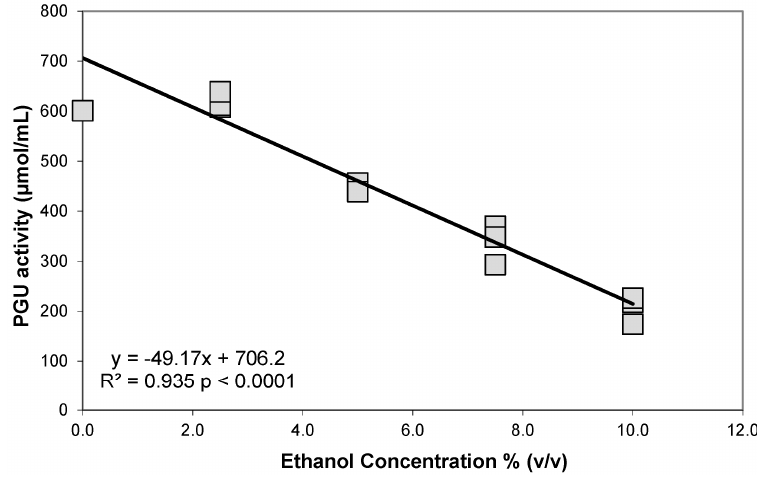
Figure 3. Impact of ethanol on polygalacturonase (PGU) activity in Scottzyme Color X (pH = 3.5; temperature = 30 °C), measured in sodium acetate buffer solution. Each PGU value associated with each individual ethanol value is based upon four determinations.